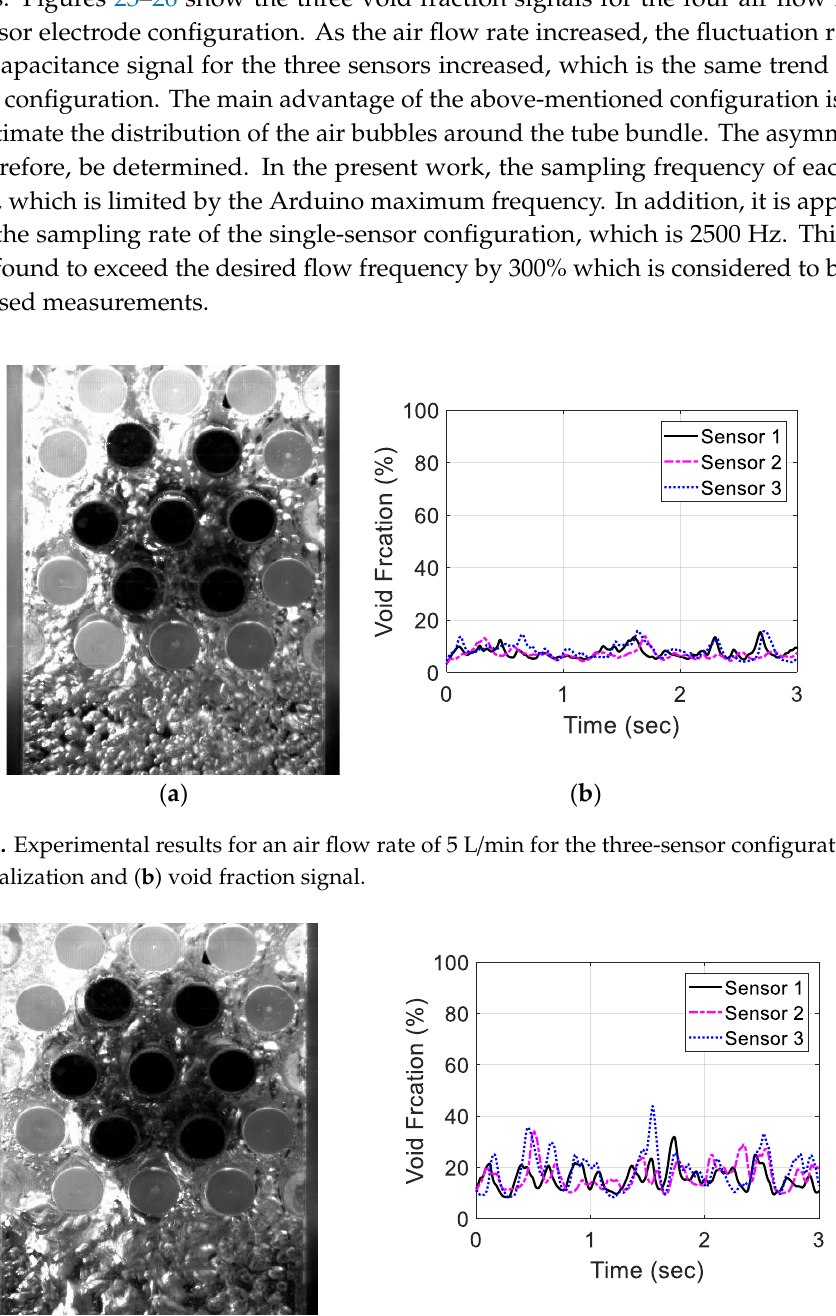
Table 3. Average void fraction data for different air flow rates using the three-sensor configuration.